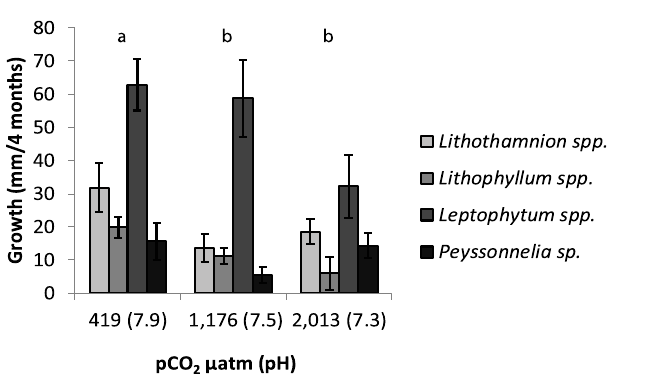
Figure 1. Surface morphology for each morphological group. Scientific names based on DNA sequencing of 5–10 samples/group. ( a ) Morphological group 1: Five samples of Group 1 were sequenced, with three identified as Lithothamnion phymatodeum and two as L. glaciale . Lithothamnion spp. specimens had raised multiporate conceptacles (~500 µ m width) and short non-articulated protuberances that appear as distinct bumps on the surface (~1 × 1 × 1.5 mm). ( b ) Morphological group 2: Nine samples of this group sequenced as three related, undescribed species of Lithophyllum , some of which have also been found in northern Washington (PG pers obs). Lithophyllum spp. specimens had a very thin crust with numerous, small uniporate conceptacles (~150 µ m width) that are flush with or slightly raised above the surface. ( c ) Morphological group 3: Six samples of this group were sequenced, with three identified as Leptophytum adeyi and three identified as a closely related, but undescribed Leptophytum species. Leptophytum spp. specimens were never found with conceptacles and had flowing growing margins, a very smooth surface, and fast growth in the laboratory compared to the other three groups. ( d ) Morphological group 4: Five samples were sequenced and all were a single lightly calcified aragonitic species of Peyssonnelia . These had a distinctive darker red coloration and flowing surface patterns. (Scale bars are in mm).